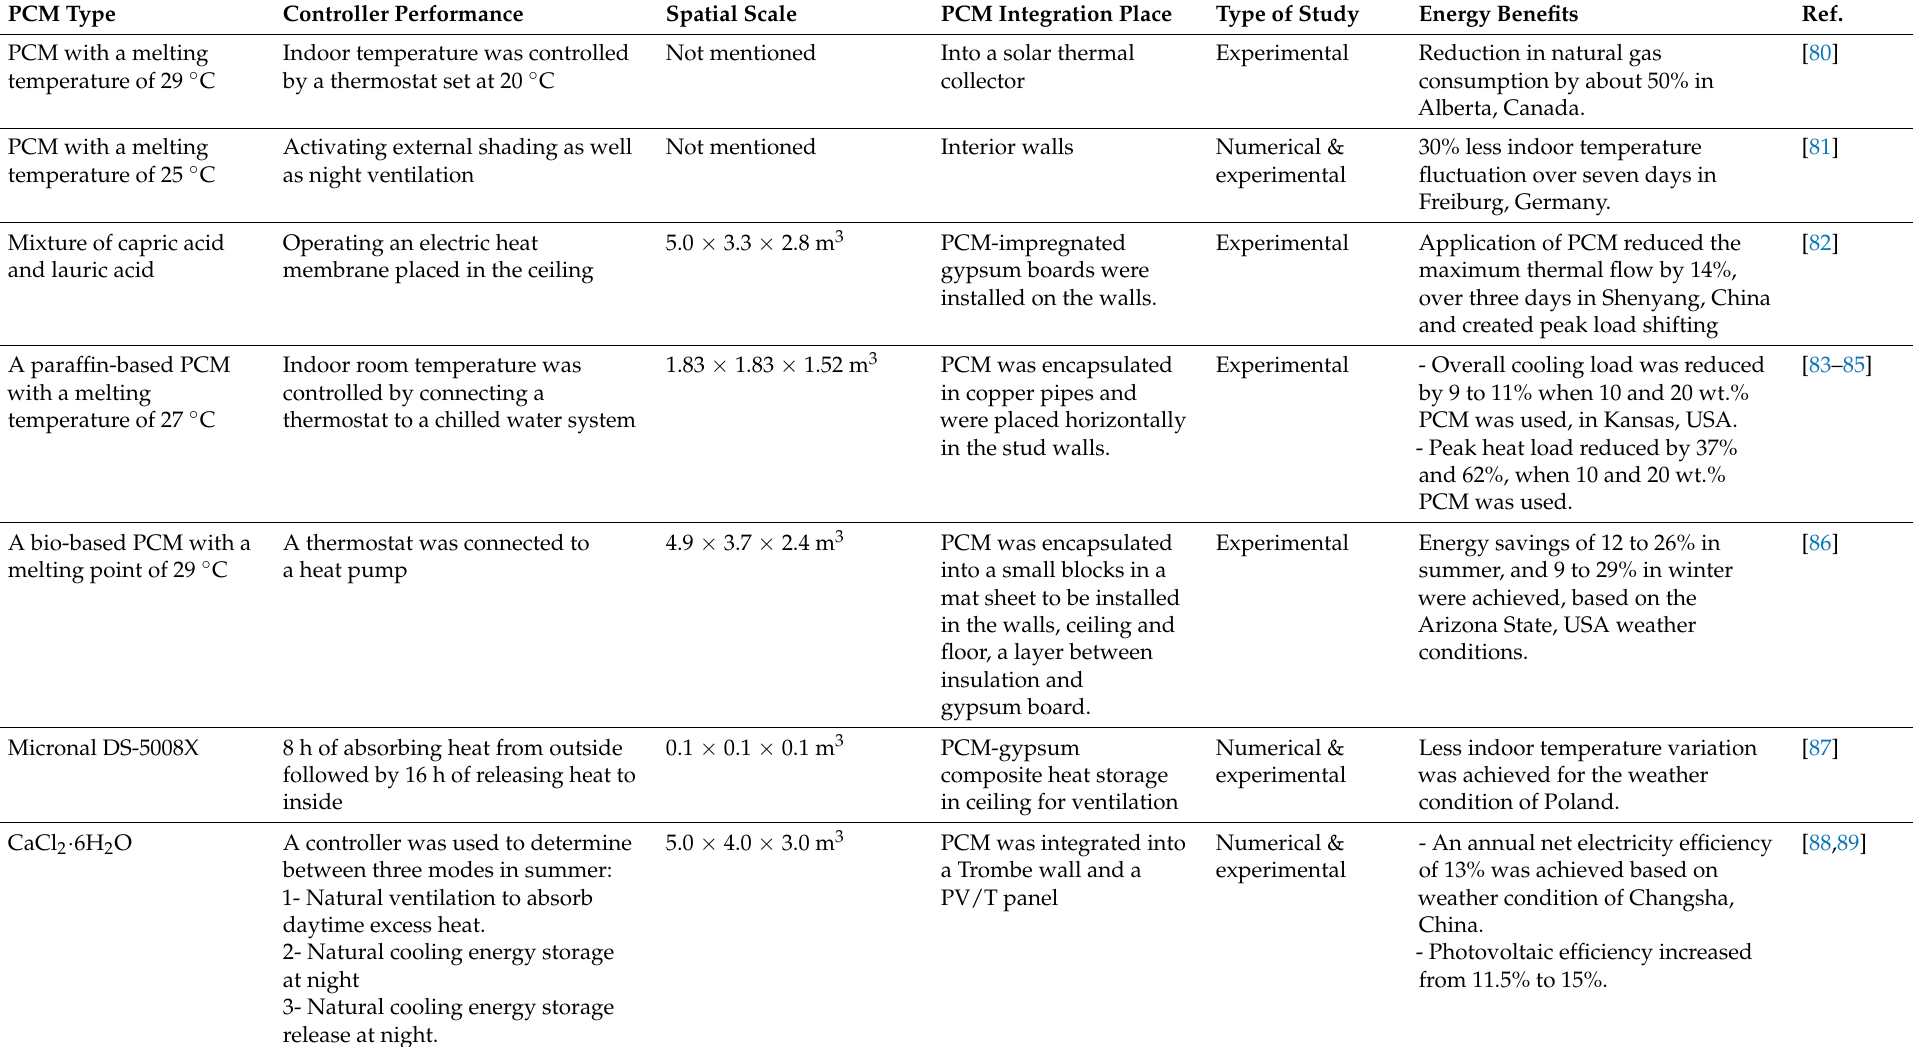
Table 2. Application of ON/OFF controller in PCM-enhanced buildings for energy consumption